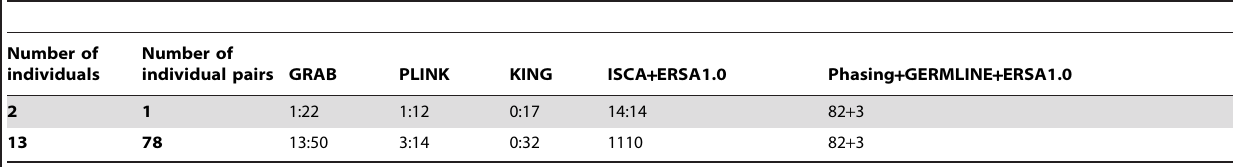
Table 4. Computation time in minutes for GRAB and other methods on sets of whole-genome sequences, using standard input data